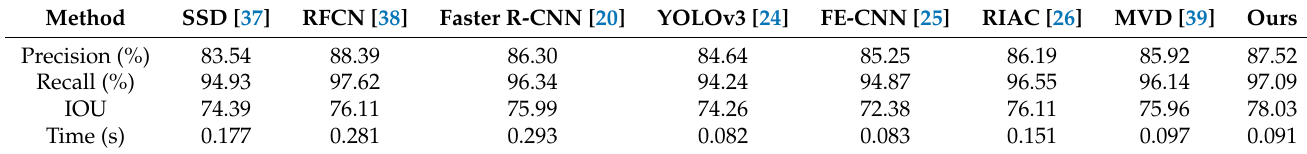
Table 3. Precision and time comparison between our method and existing algorithms for detecting single vehicle